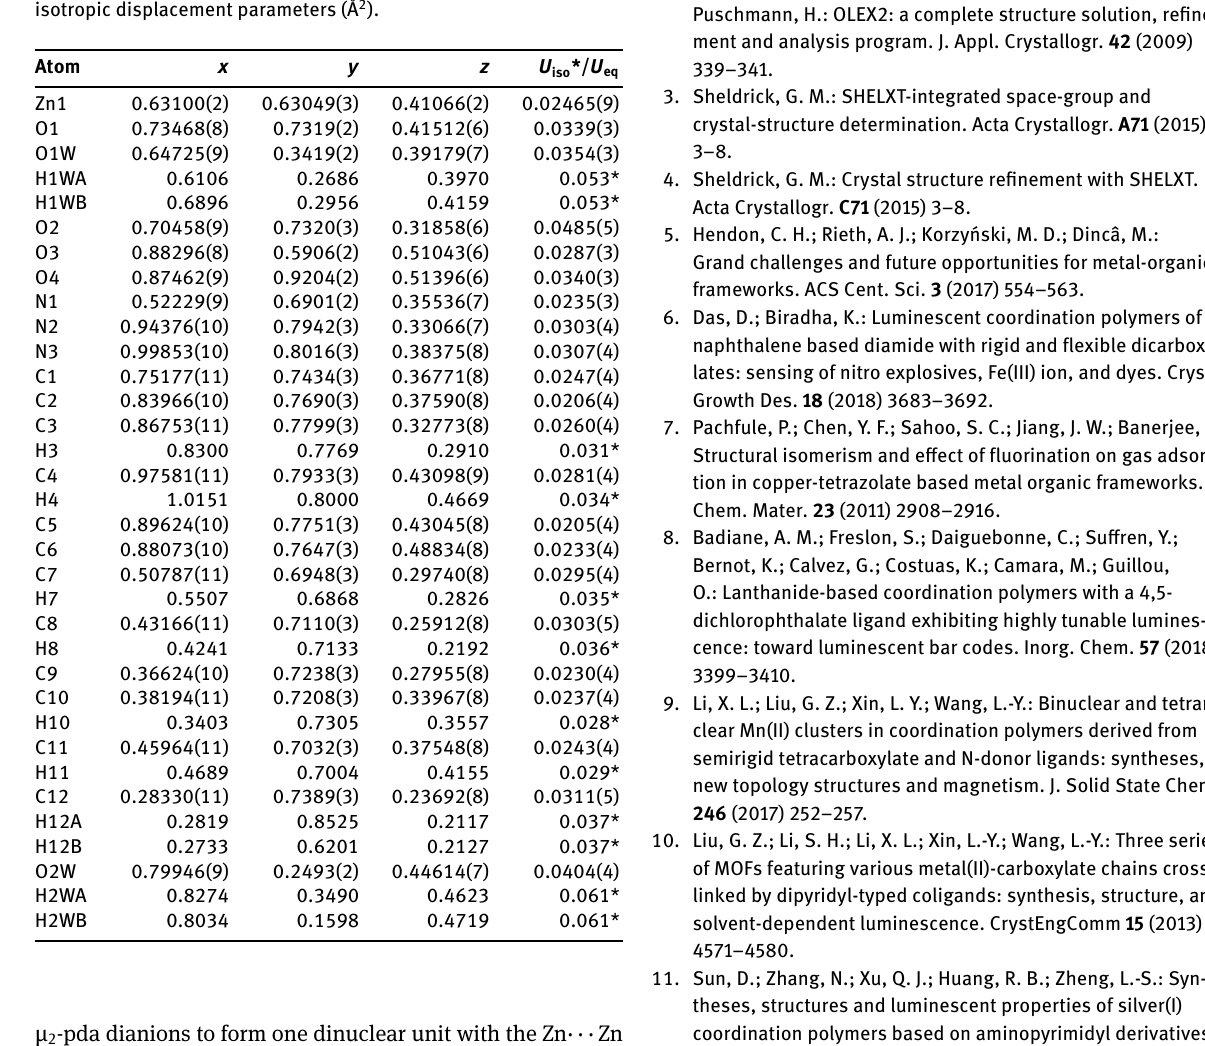
Table 2: Fractional atomic coordinates and isotropic or equivalent isotropic displacement parameters (Å 2